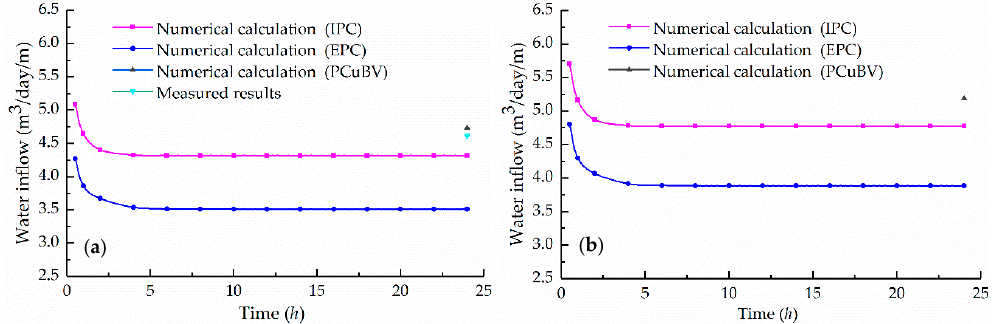
Figure 18. The compared diagrams of water inflow in the subsea tunnel. ( a ) upper section and ( b ) full-cross section